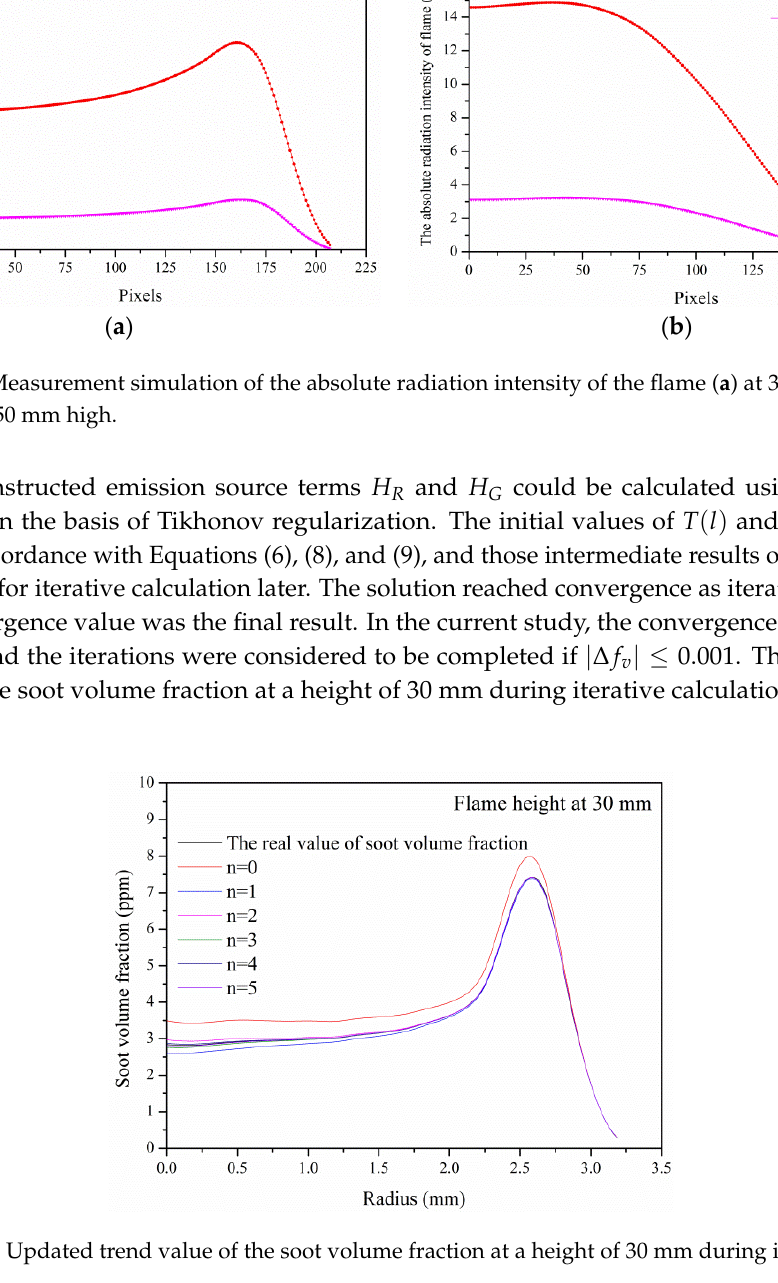
Figure 3. Updated trend value of the soot volume fraction at a height of 30 mm during iterations.